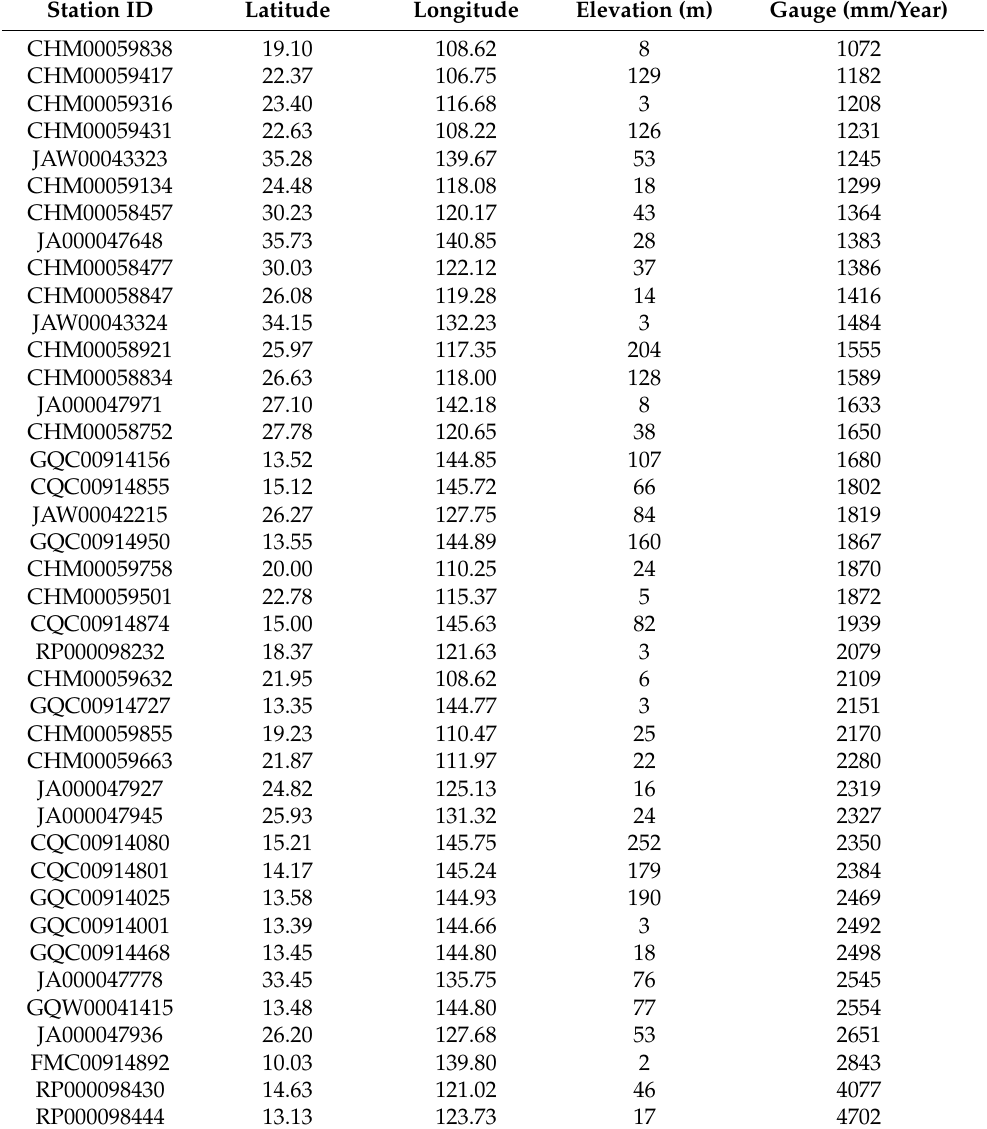
Table 2. Station descriptions for the forty-one in situ rain gauges located within 1 ◦ of the best track locations with 329 or more days of data available